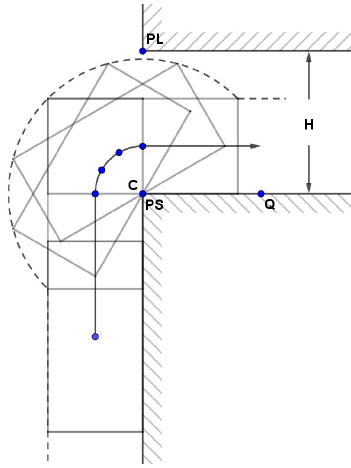
Figure 8. The trajectory of RRB when X = 0 .